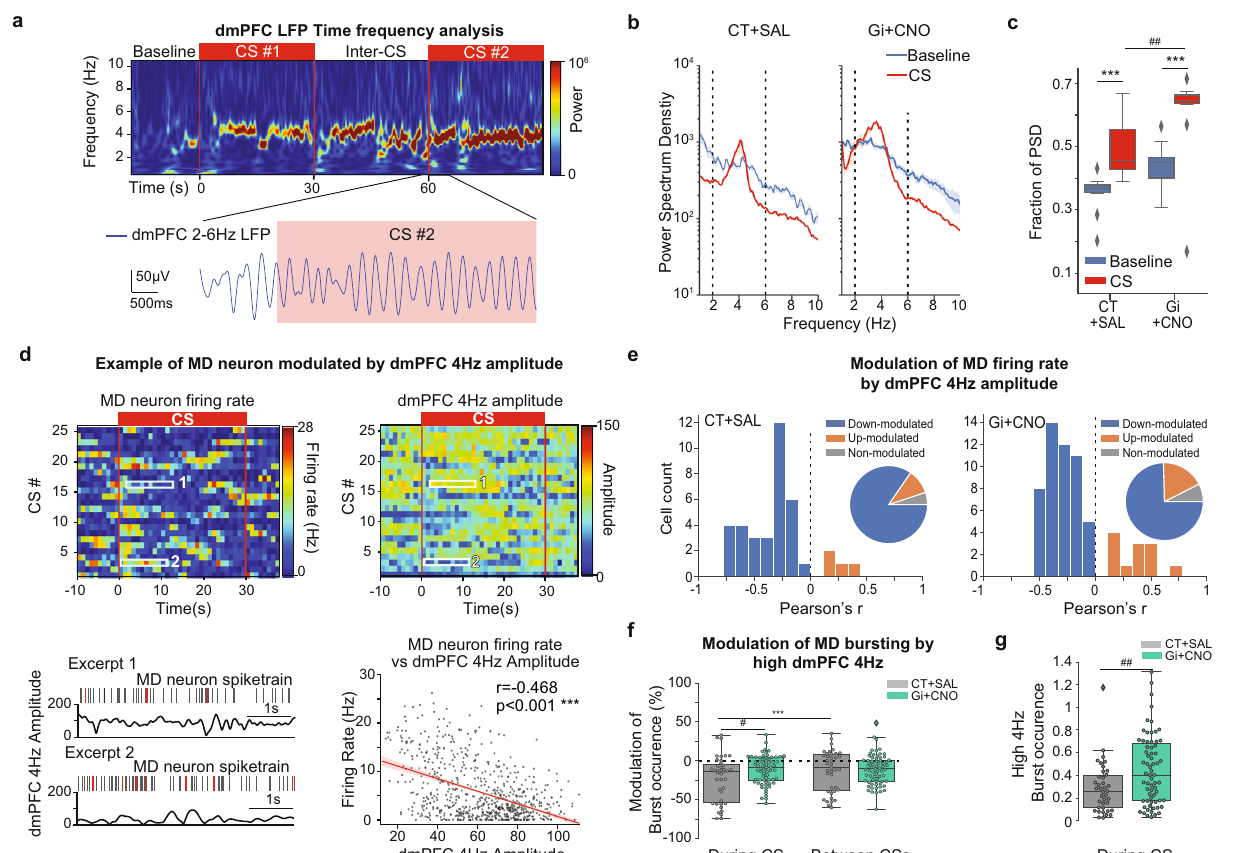
Fig. 6 | Neuronal activity in the MD is modulated by dmPFC 4Hz LFP oscilla- tionsduringEXT1.a RepresentativespectrogramofdmPFCLFPduringEXT1(top), displaying a 4Hz component induced by the CS. 2 – 6Hz fi ltered LFP traces from dmPFC(blue),showing the apparitionof 4Hzoscillations after the onset of the CS (red rectangle). b A 4Hz component (2 – 6Hz) is visible in the Power Spectrum Density (PSD) dmPFC LFP during EXT1 for CT+SAL (left) and Gi+CNO (right), average±SEM,dashedlinesrepresentthe4Hzrange(2 – 6Hz). c Thefractionofthe PSD representing 2 – 6Hz oscillations is increased during Extinction compared to Baseline.Wilcoxontest,*** p <0.001.ThefractionofthePSDduringCSisincreased inGi+CNOcomparedtoCT+SAL,Mann – Whitney U test,## p <0.01(CT+SAL=14 recording sites from 4 mice, Gi+CNO=15 recording sites from 5 mice). d Average fi ring rate of a MD neuron during EXT1, centered on the onsets of CSs (top left), binned average amplitude 4Hz oscillations in the dmPFC (top right). Example rasterandcorrespondingtraceofamplitude4HzoscillationsinthedmPFC,bursts aredisplayedinred(bottomleft).Scatterplotdisplayingtheaveraged fi ringrate(1s